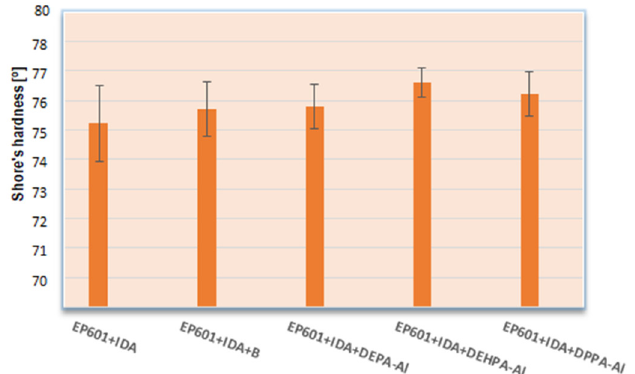
Figure 12. Shore’s hardness of composites